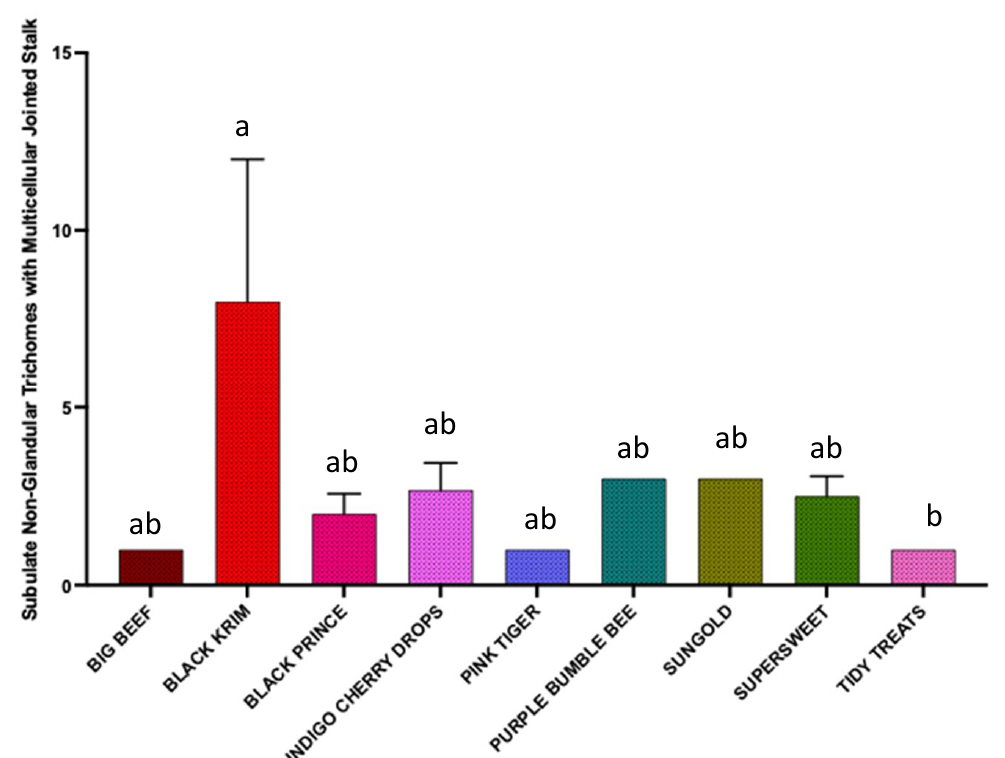
Fig. 8 The comparison of total number of subulate non-glandular hair with multicellular stalk, multicellular base, and distinct subsidiary cells trichome present in ten varieties of tomato